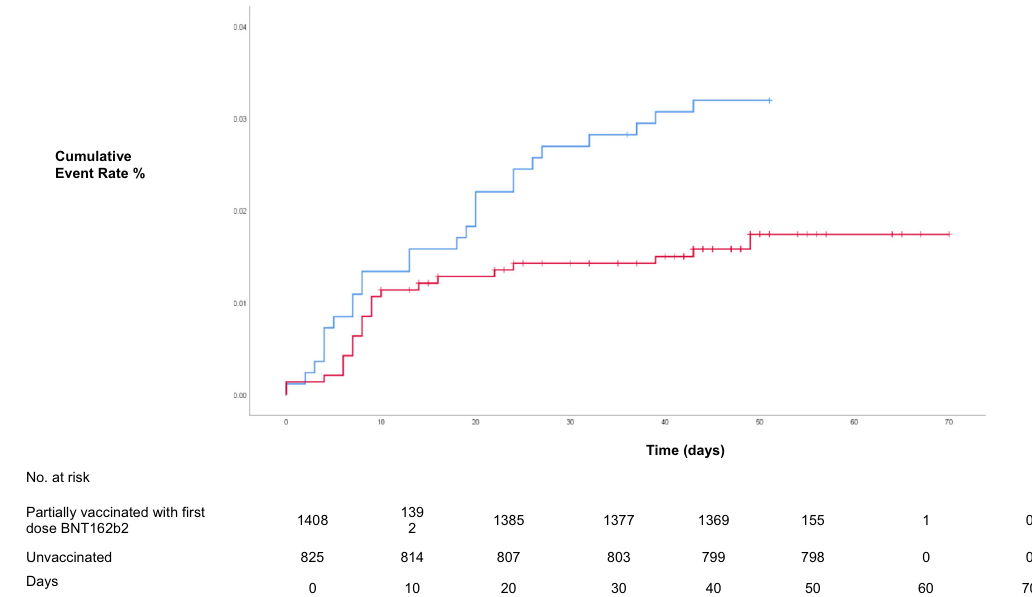
Fig. 3 Kaplan – Meier estimates of time to fi rst occurrence of COVID-19 in vaccinated and unvaccinated HCWs. In all, 23 of 1408 from the partially vaccinated and 26 of 825 from the unvaccinated group were identi fi ed as new COVID-19 cases during the follow-up period. Up to day 13, there was no signi fi cant difference in the cumulative risk of new COVID-19 infection between both groups. From day 14, there was a signi fi cant reduction in the cumulative risk of new COVID-19 infection among partially vaccinated HCWs.